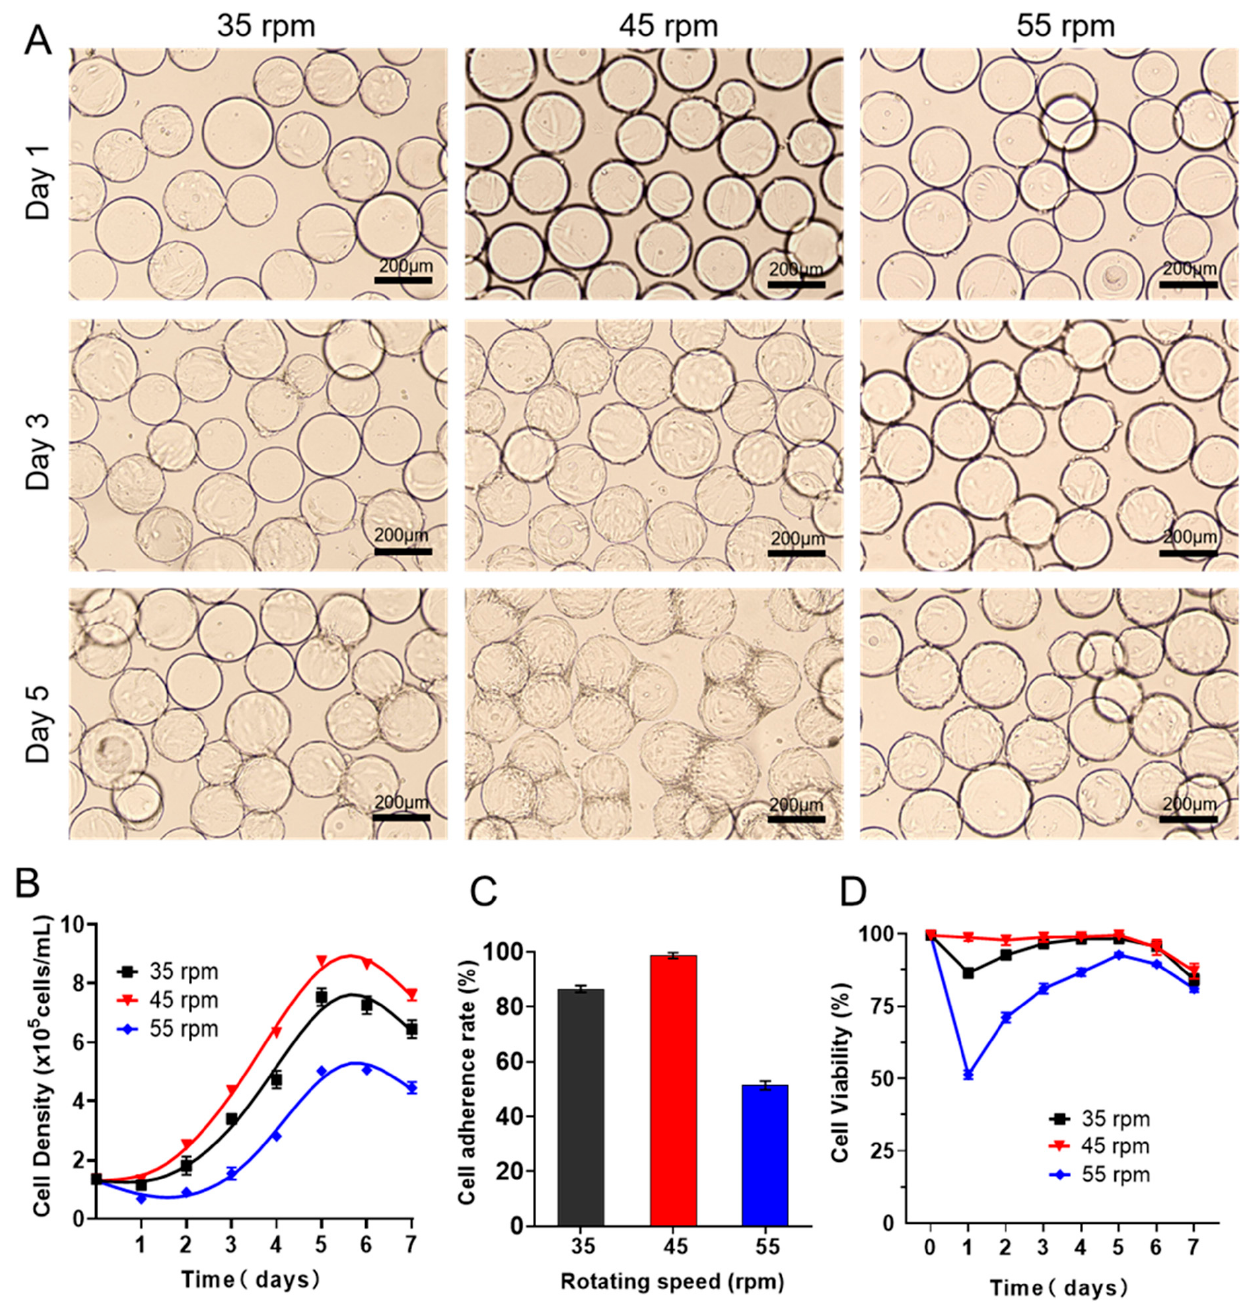
Figure 1. Expansion of batch-cultured hUCMSCs in 3D spinner flask. ( A ) Representative images of hUCMSCs on Cytodex3 cultured in 3D spinner flask with different rotating speeds (35 rpm, 45 rpm, 55 rpm). ( B ) Cell density changes when culturing the P3 hUCMSCs for 1–7 days. ( C ) Cell adherence rate on day 1 after seeding. ( D ) Cell viability during expansion of hUCMSCs. Data expressed as the mean ± standard deviation ( n = 3 per group, per time point).